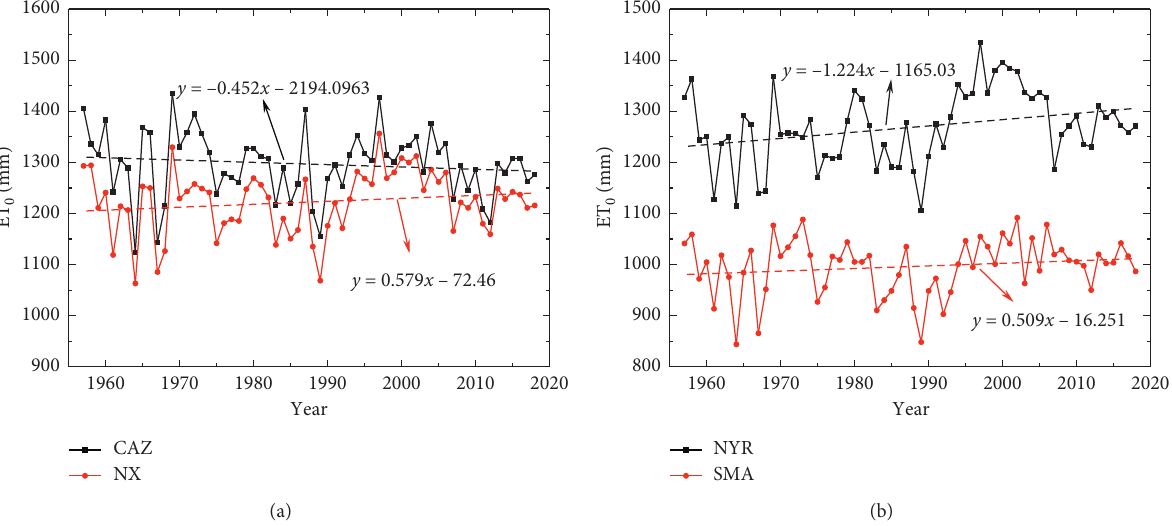
Figure 10: Temporal variations of annual ET 0 from 1957 to 2018 over the NX, NYR, CAZ, and